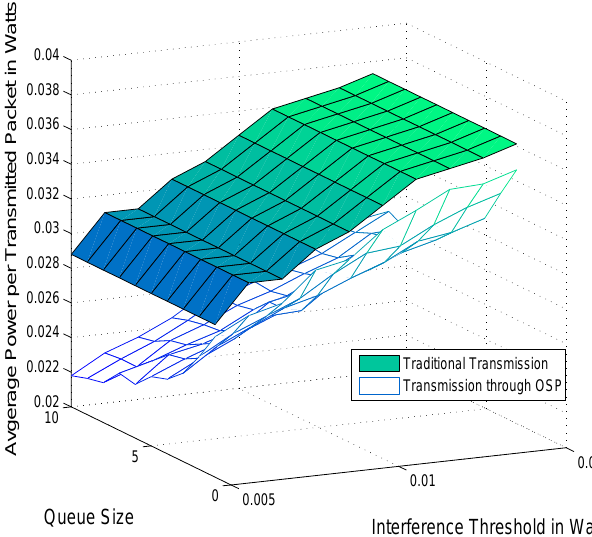
Figure 2. Dropped Packet Rate in Traditional Transmission Method versus transmission through OSP with Q=8.